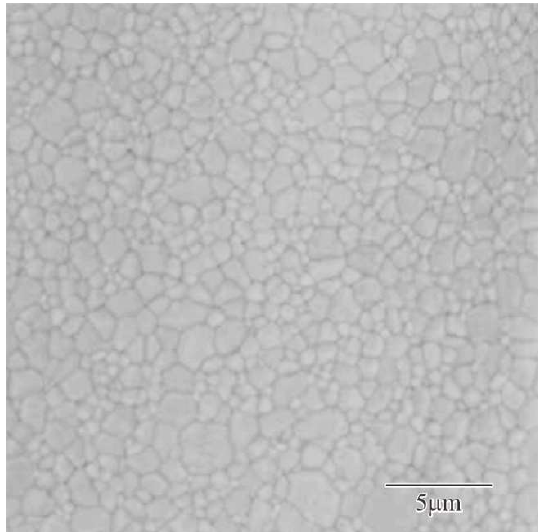
Figure 11. Ceramic microstructure of the sintered solid electrolyte in the dendritic microlattices observed by scanning electron microscopy (SEM). The fine crystal grains of the yttria-stabilized zirconia (YSZ) were obtained by systematically optimized heat treatments at 1400 °C for 2 h in air.